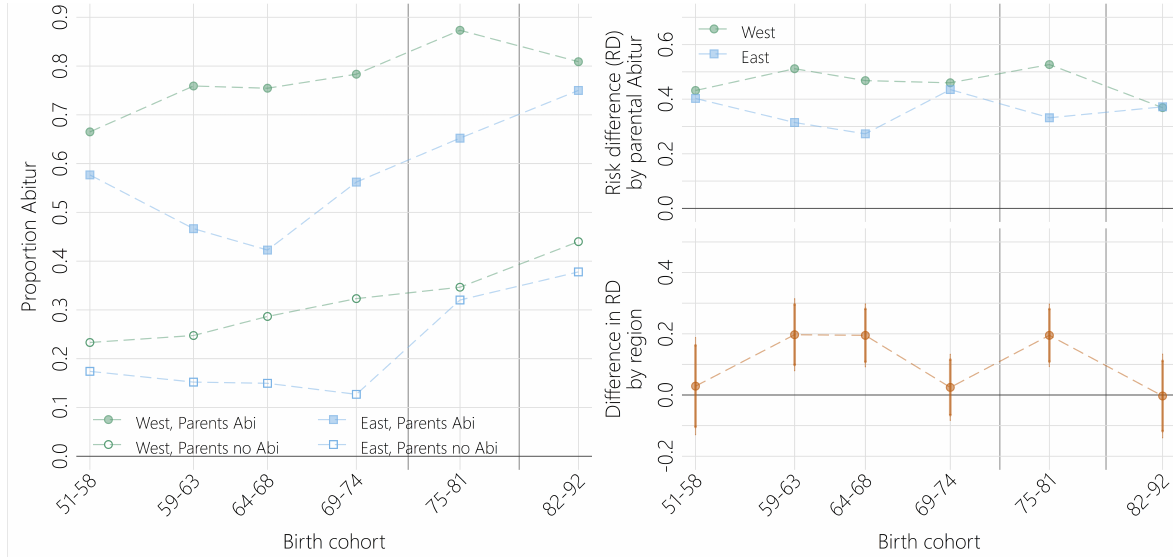
Figure 4: Change in IEO across birth cohorts in East and West Germany before and after reunification. Risk differences pertain to parental education. Difference in risk difference pertains to East and West Germany. The first vertical line indicates the timing of reunification. Subsequent vertical lines differentiate birth cohorts according to the timing of educational transitions after